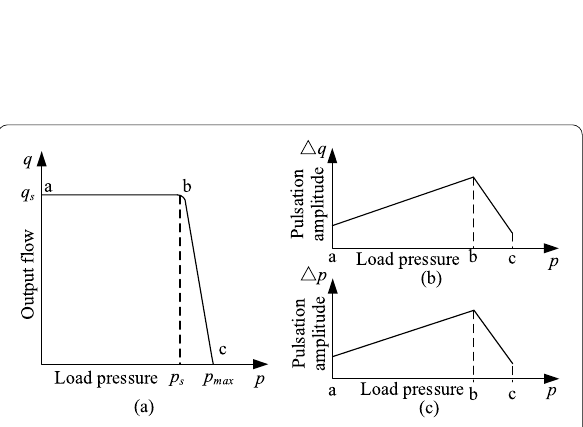
Figure 32 Flow-pressure and pulsation-pressure characteristics of constant pressure variable displacement pump: a flow-pressure characteristics, b flow pulsation-pressure characteristics, c pressure pulsation-pressure